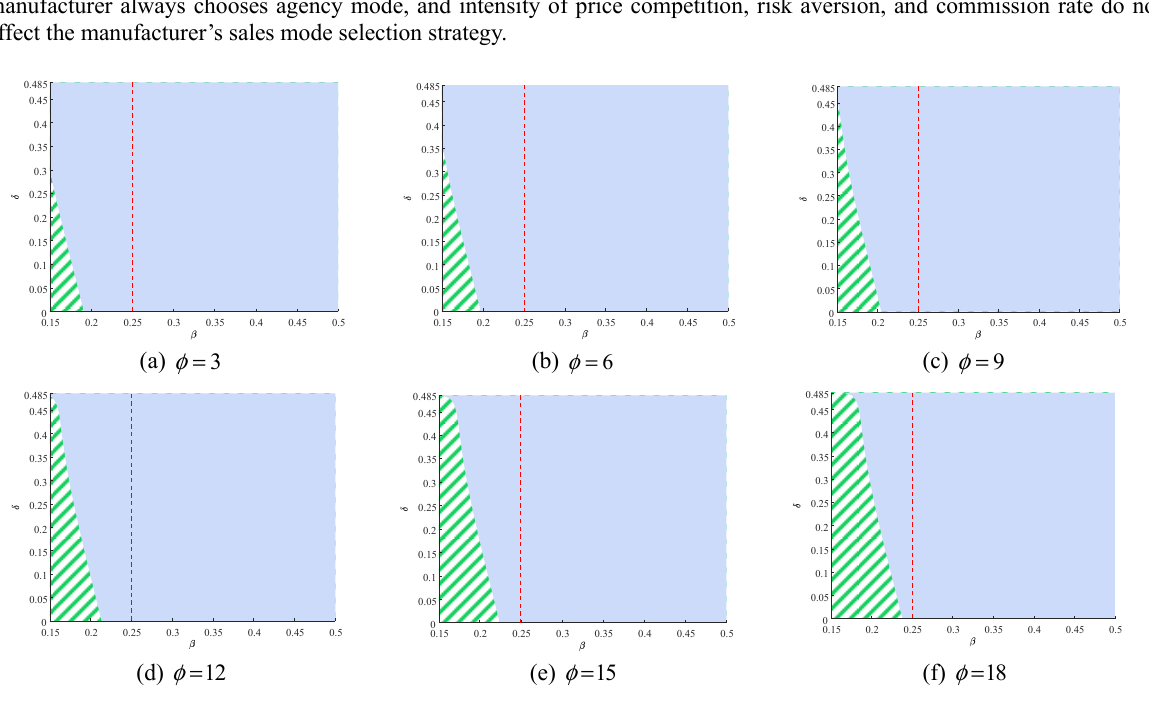
Fig. 5. Manufacturer’s sales mode selection under high commission